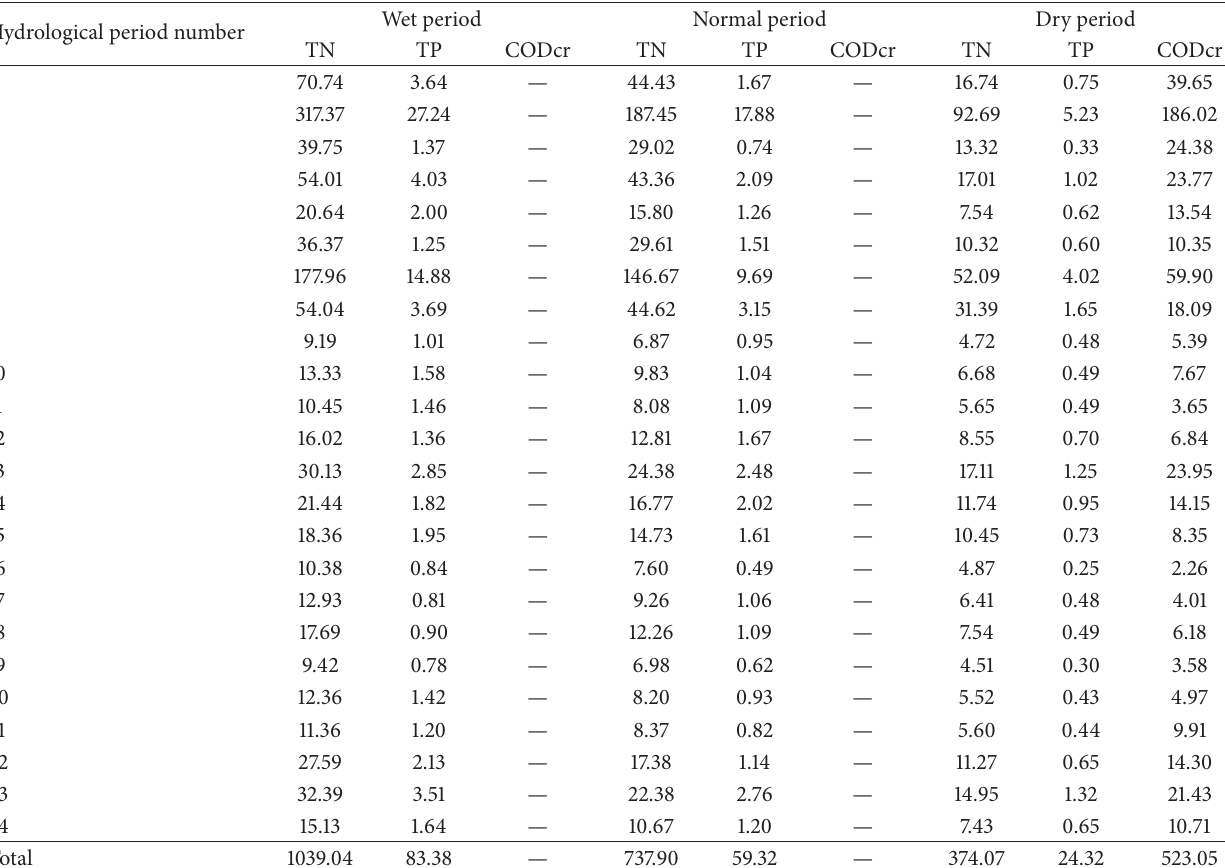
Table 4: The reductions of pollution load in Erhai Lake 𝑡/𝑎